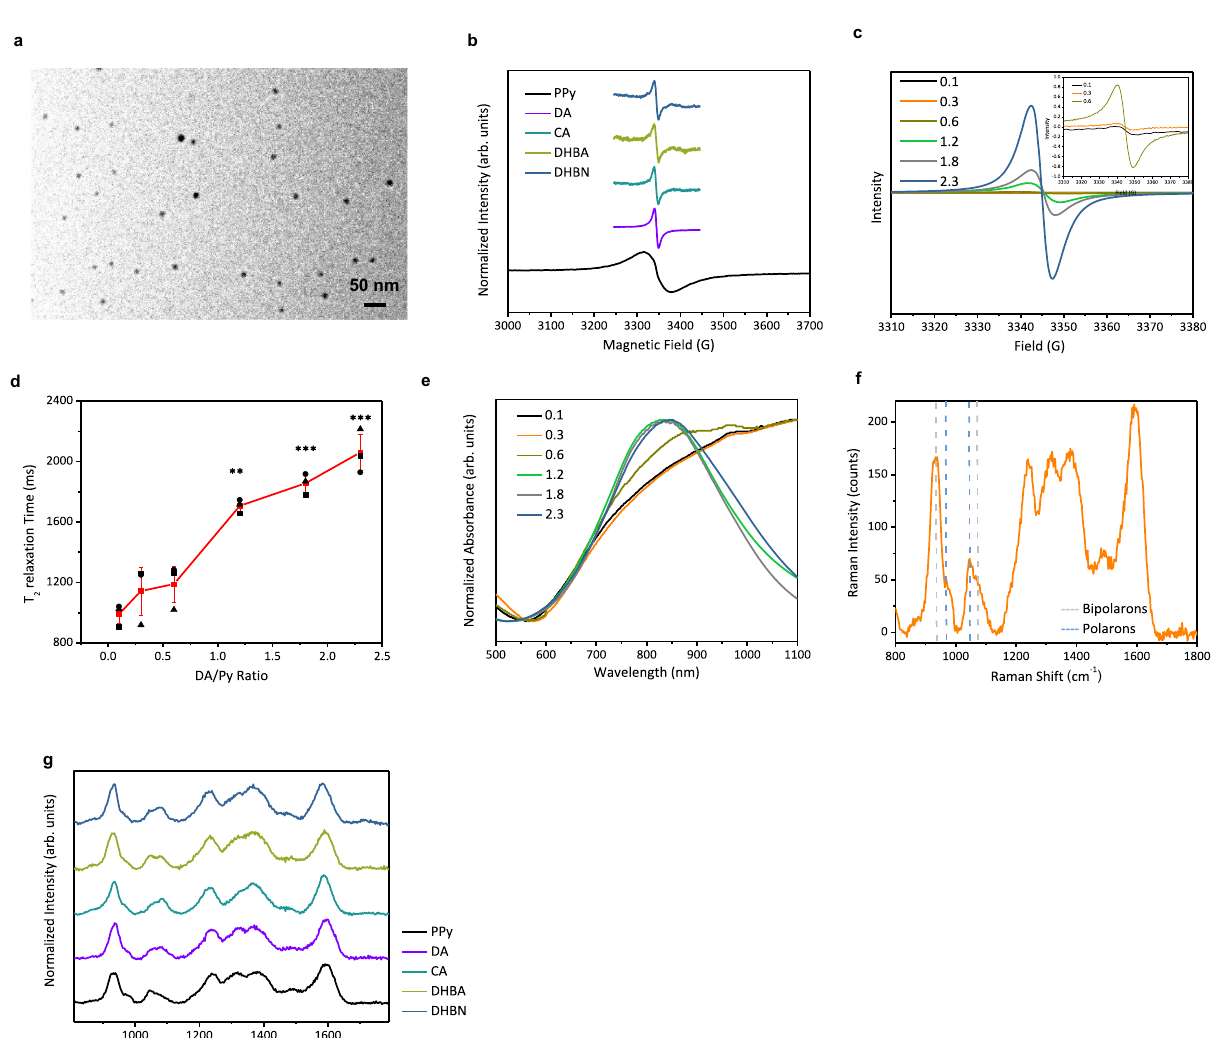
Fig. 1 Investigating the T 2 MRI properties in PPy nanoparticles. a A representative transmission electron microscopy (TEM) image of catechol – PPy nanoparticles. Experiments were performed three times with similar results. b ESR spectra of pristine and catechol – PPy nanoparticles. All spectra were measured in dry powders of PPy nanoparticles. c ESR spectra of DA – PPy nanoparticles prepared with different amount of dopamine. All spectra were measured in dry powders of PPy nanoparticles. d T 2 relaxation times of 1 mg/mL DA – PPy nanoparticles in aqueous solutions. Error bars in d represent mean±s.d., with n = 3 independent experiments. Statistical signi fi cance for comparison of 0.1 DA – PPy and other DA – PPy nanoparticles was determined